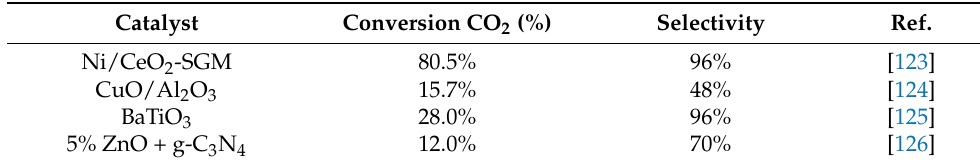
Table 3. Results of some studies in thermal plasma processes to improve CO 2 conversion and selectivity by metal